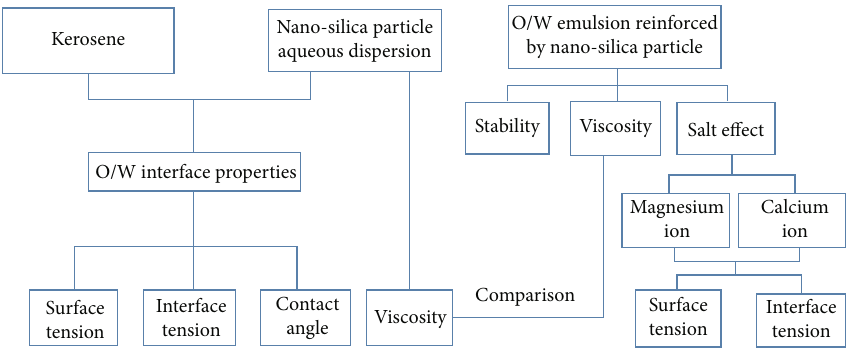
Figure 1: The general sketch of the study.